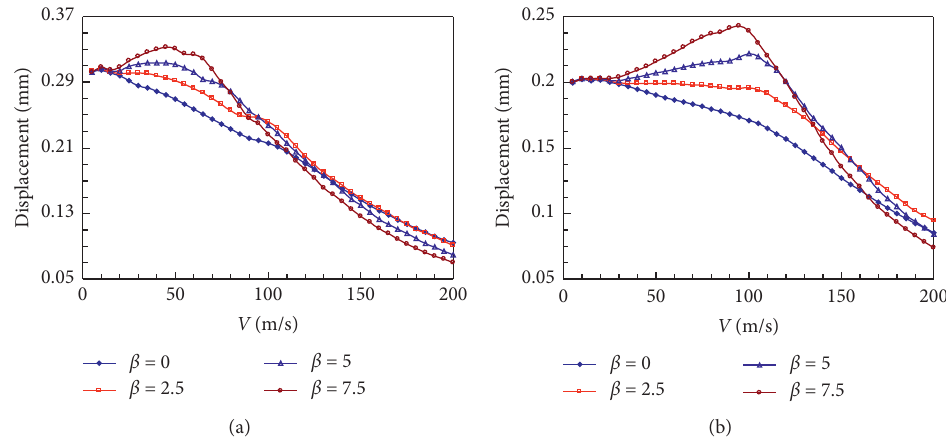
Figure 12: The maximum displacements of the track with various shear stiffness: (a) k